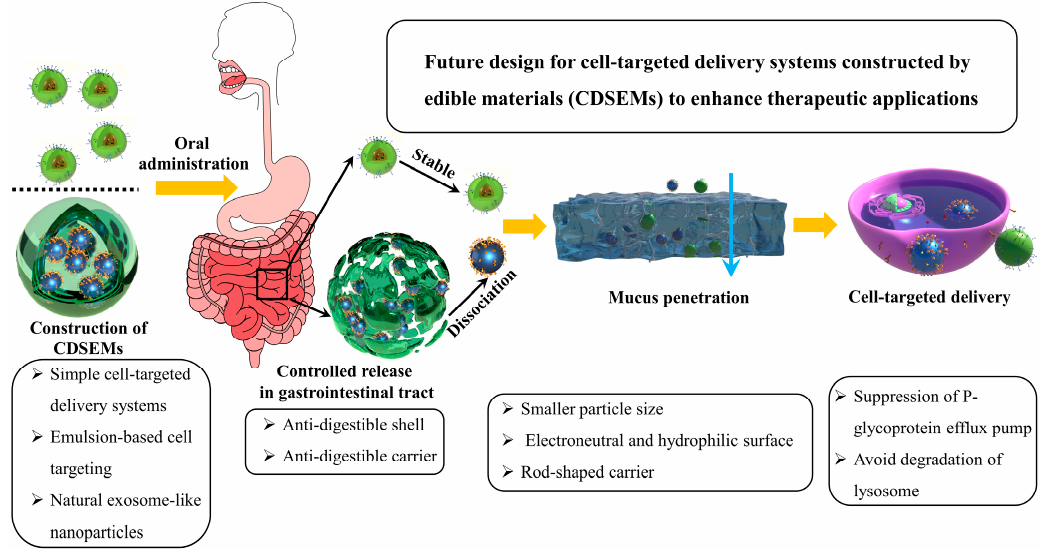
Figure 4. Multi-angle approaches for the development of cell-targeted delivery systems constructed of edible materials (CDSEMs) for advanced delivery.